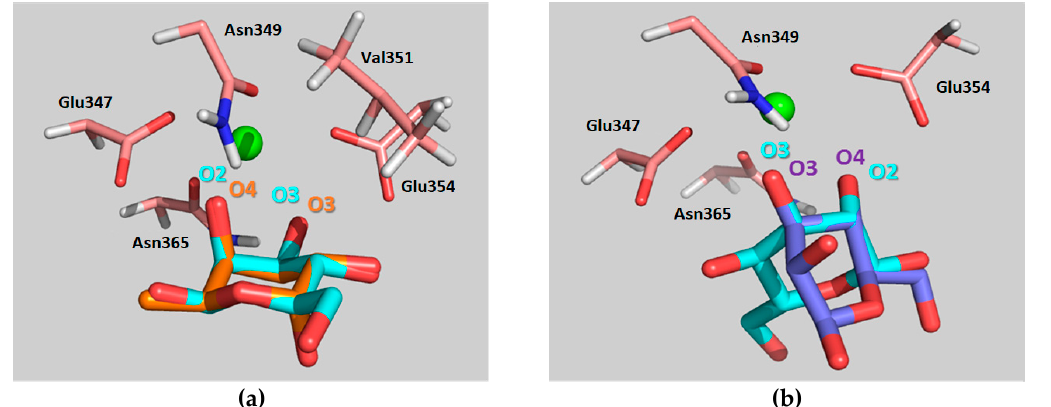
Figure 5. Representative structures of β -4-F-Man binding pose A, mimicking Fuc ( a ) and binding pose B, mimicking Man ( b ).